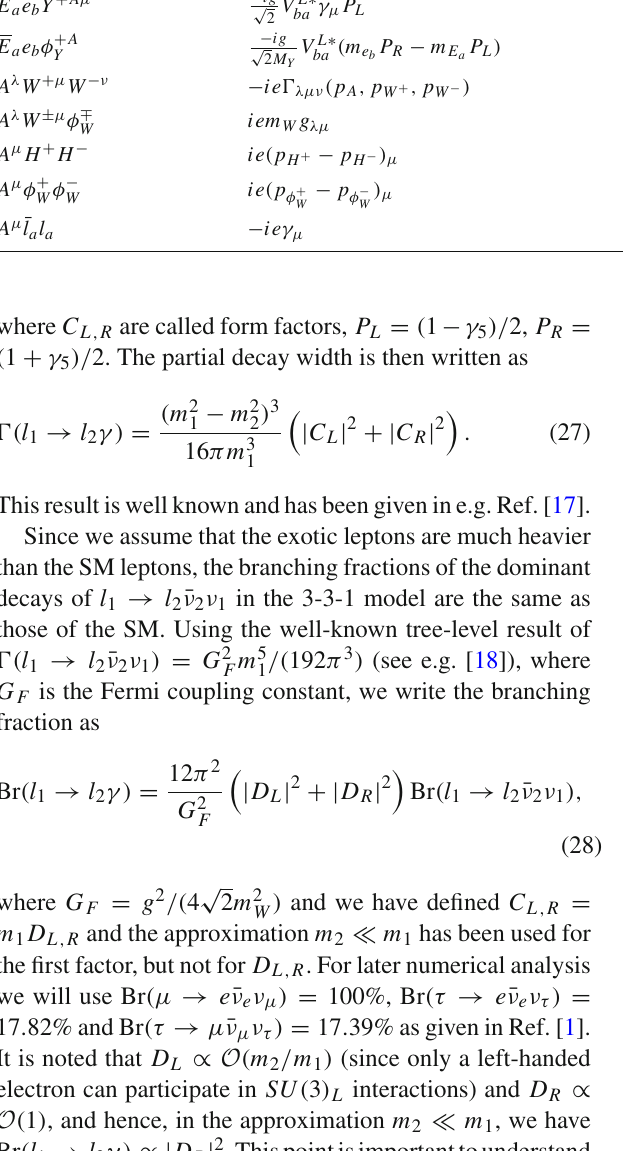
Table 1 Vertices and couplings for l i → l j γ decays in the 3-3-1 model with arbitrary β and new leptons. All momenta are defined as incoming. The photon field is denoted as A μ , a , b = 1 , 2 , 3 are family indices and Vertex Coupling